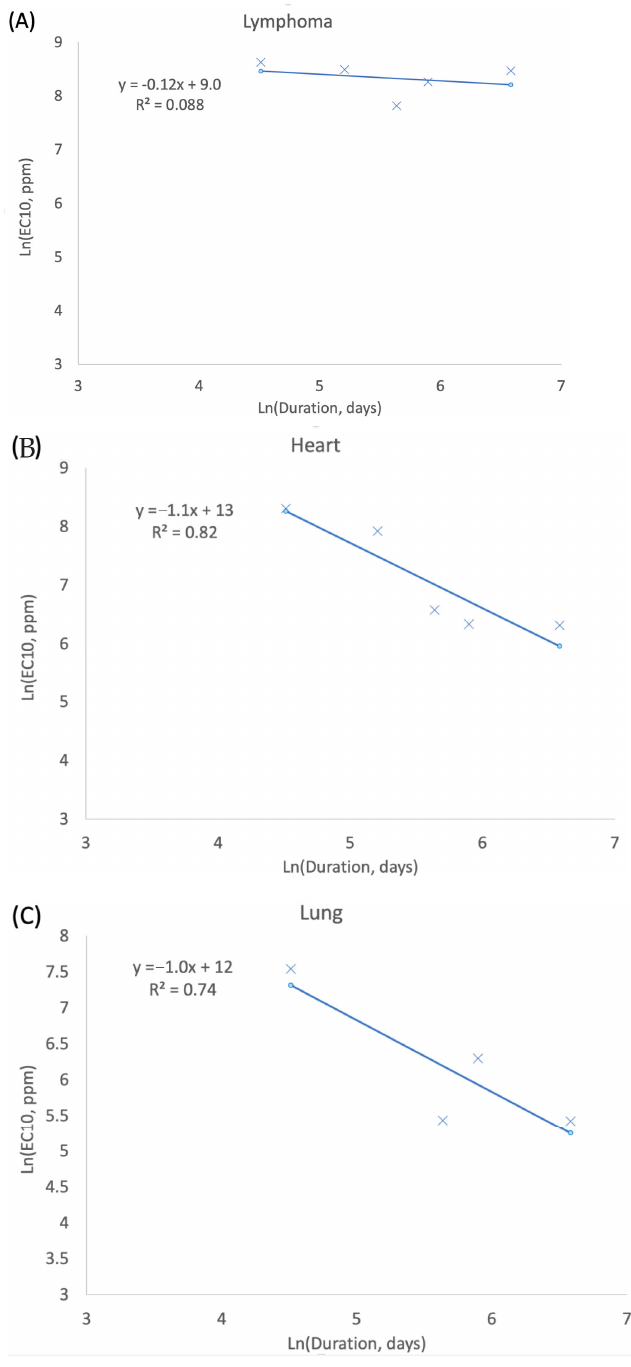
Figure 2. CxT assessment for select tumors in male mice exposed to BD (lifetime and stop ‐ exposure study data): ( A ) lymphomas; ( B ) heart tumors; ( C ) lung tumors.